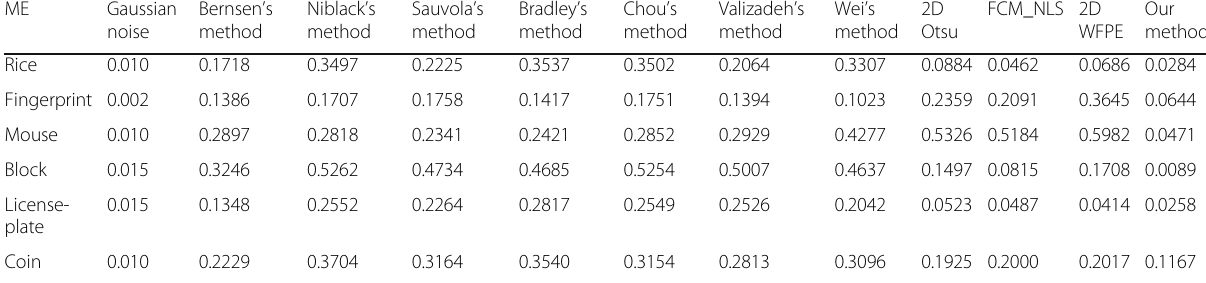
Table 1 Missclassfication rate (ME) obtained by the eight methods on images corrupted by addictive noise